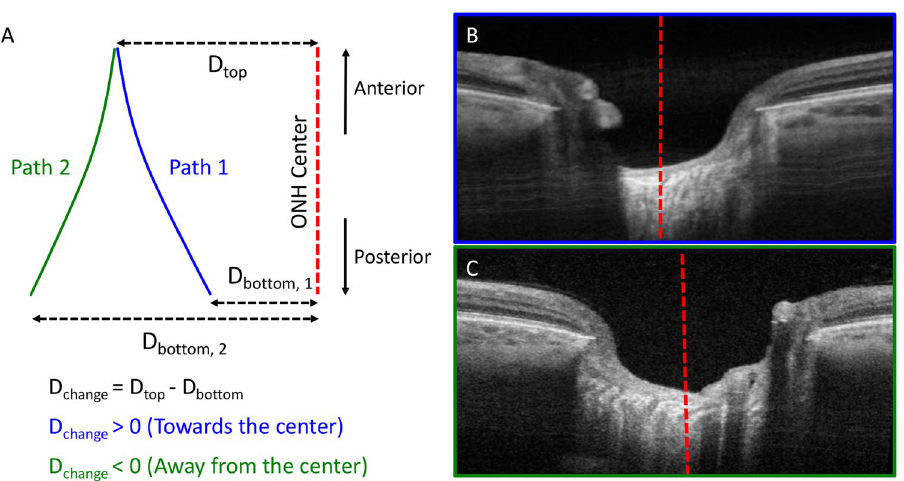
Figure 2. Identification of pore path relative to the disc. ( A ) Method of identification of pore path relative to the central disc (dotted red line). Positive distance change (path 1; blue) indicated convergence towards the center, while negative distance change (path 2; green) indicated convergence away from the center. ( B ) Example of LC identified to have pores going towards the disc center (red dotted line) and ( C ) away from disc